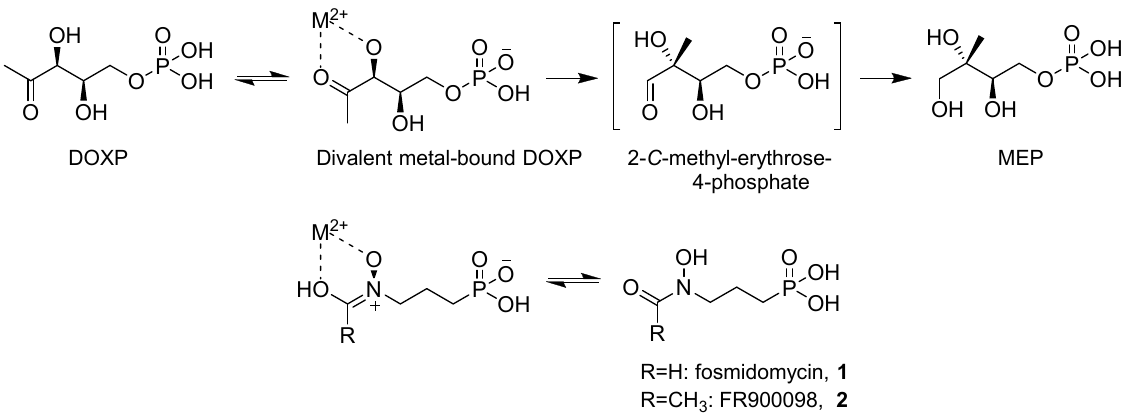
Figure 1. Analogy between DOXP and